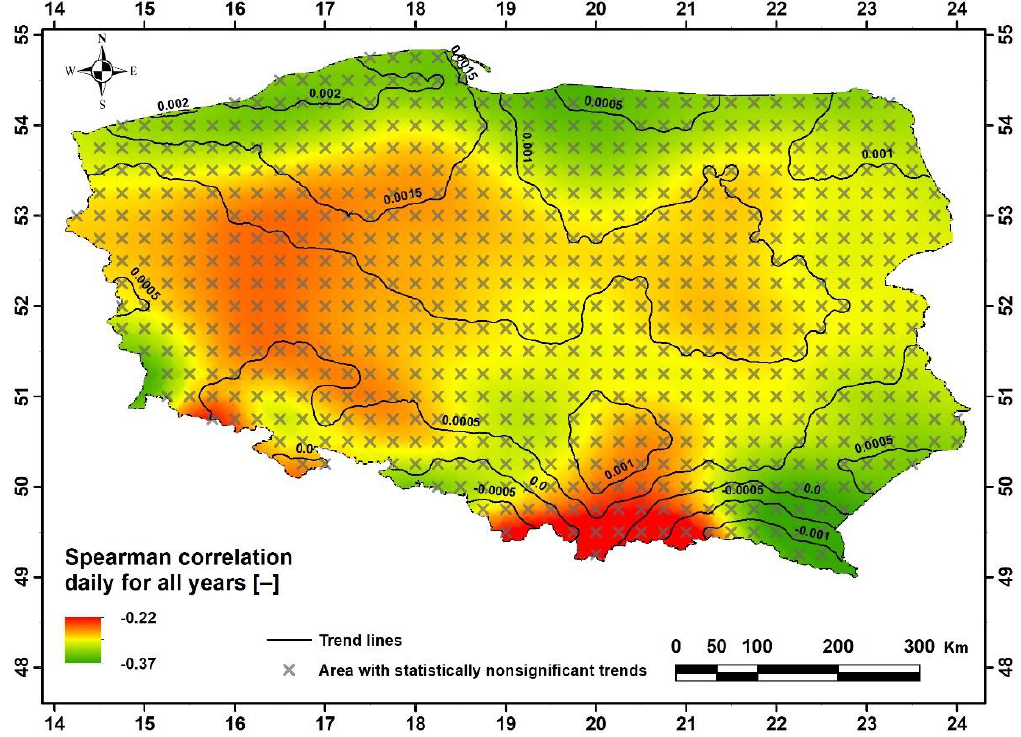
Figure 9. Complementarity between solar and wind resources based on daily sums of resources availability, 1980 – 2019. Crosses show where trends (isolines) are not statistically significant.